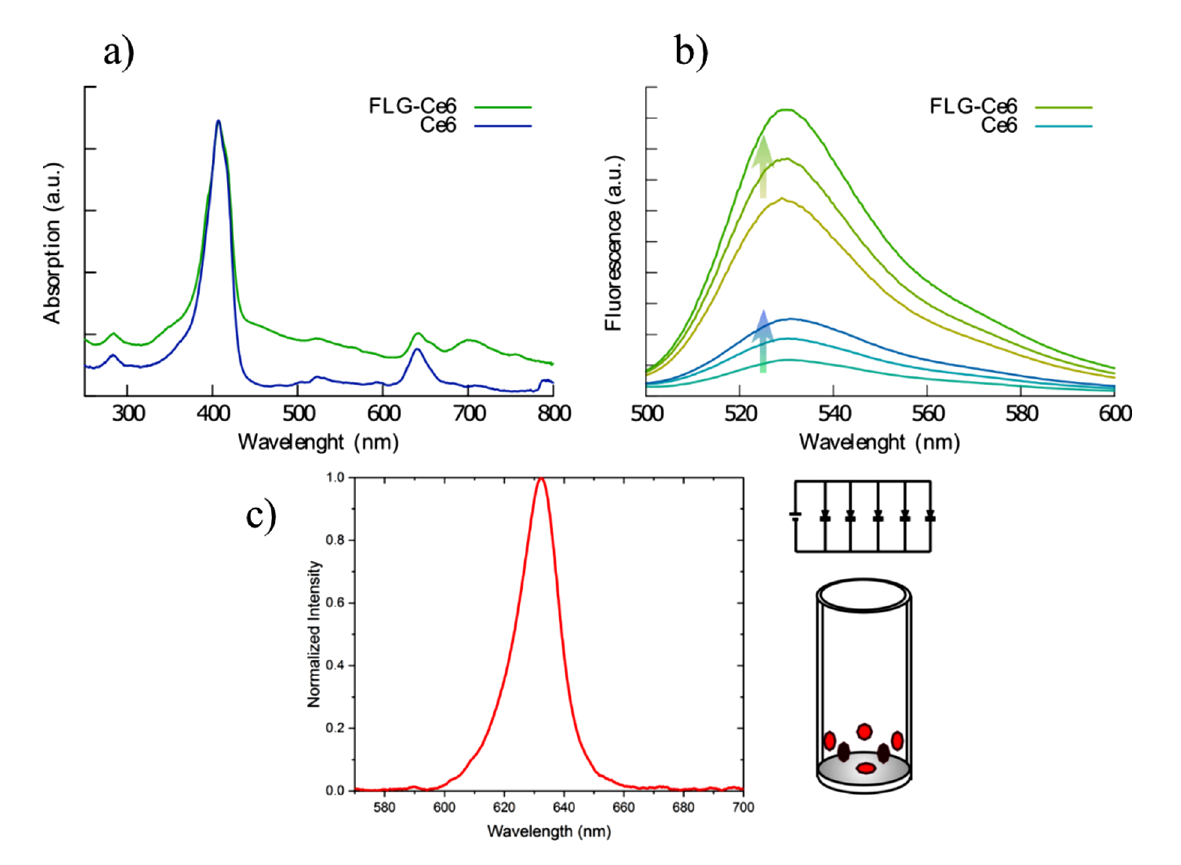
Figure 3: ROS production and PDT system characterization. a) UV–vis absorption spectra of pristine Ce6 (blue) and FLG-Ce6 (green). b) Singlet oxygen production assays. Singlet oxygen is indirectly observed through the fluorescence of the reporter molecule, singlet oxygen sensor green reagent; the higher fluorescence is related to higher singlet oxygen production. The ascending arrows denote the irradiation time (5, 10 and 15 min). c) Details of the LED excitation source. The LED emission spectrum is centered at 632 nm, as shown on the left, and a scheme of the 6 LEDs array is shown on the right.